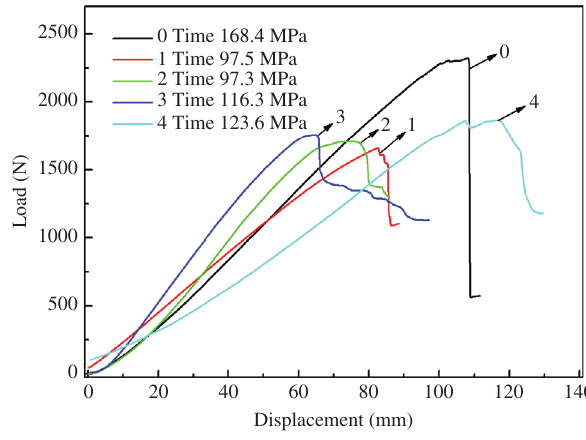
Figure 11 The flexural load-displacement curves of different samples.